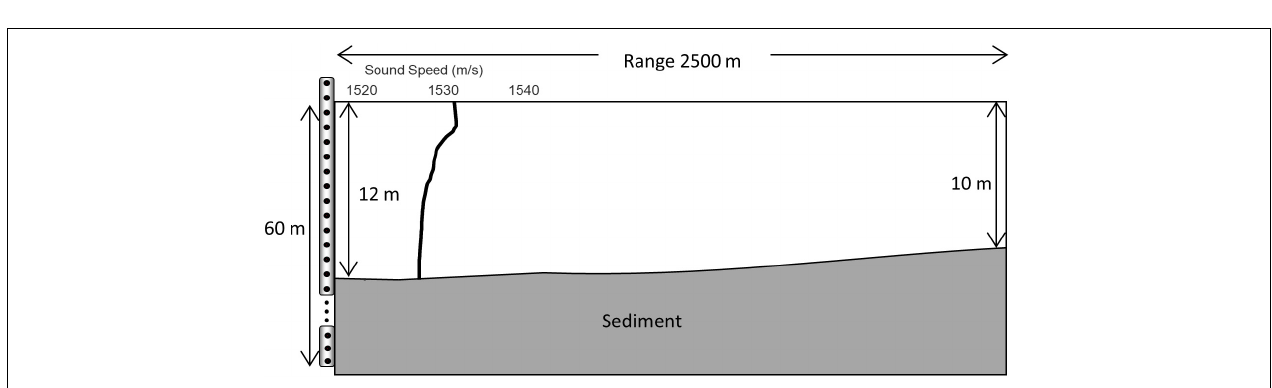
FIGURE 7 | Measured depth-averaged sound exposure levels (red circles) as a function of distance and a comparison with model predictions. Thick dashed line is the best-fitted DCSM predictions obtained using a reference range of 288 m. Two thin gray dashed lines represent upper and lower bounds of the DCSM predictions obtained using decay factors estimated from the combination of input parameters listed in Table 2 . The blue solid line represents the depth-averaged sound exposure level curve predicted by the broadband PE simulation.